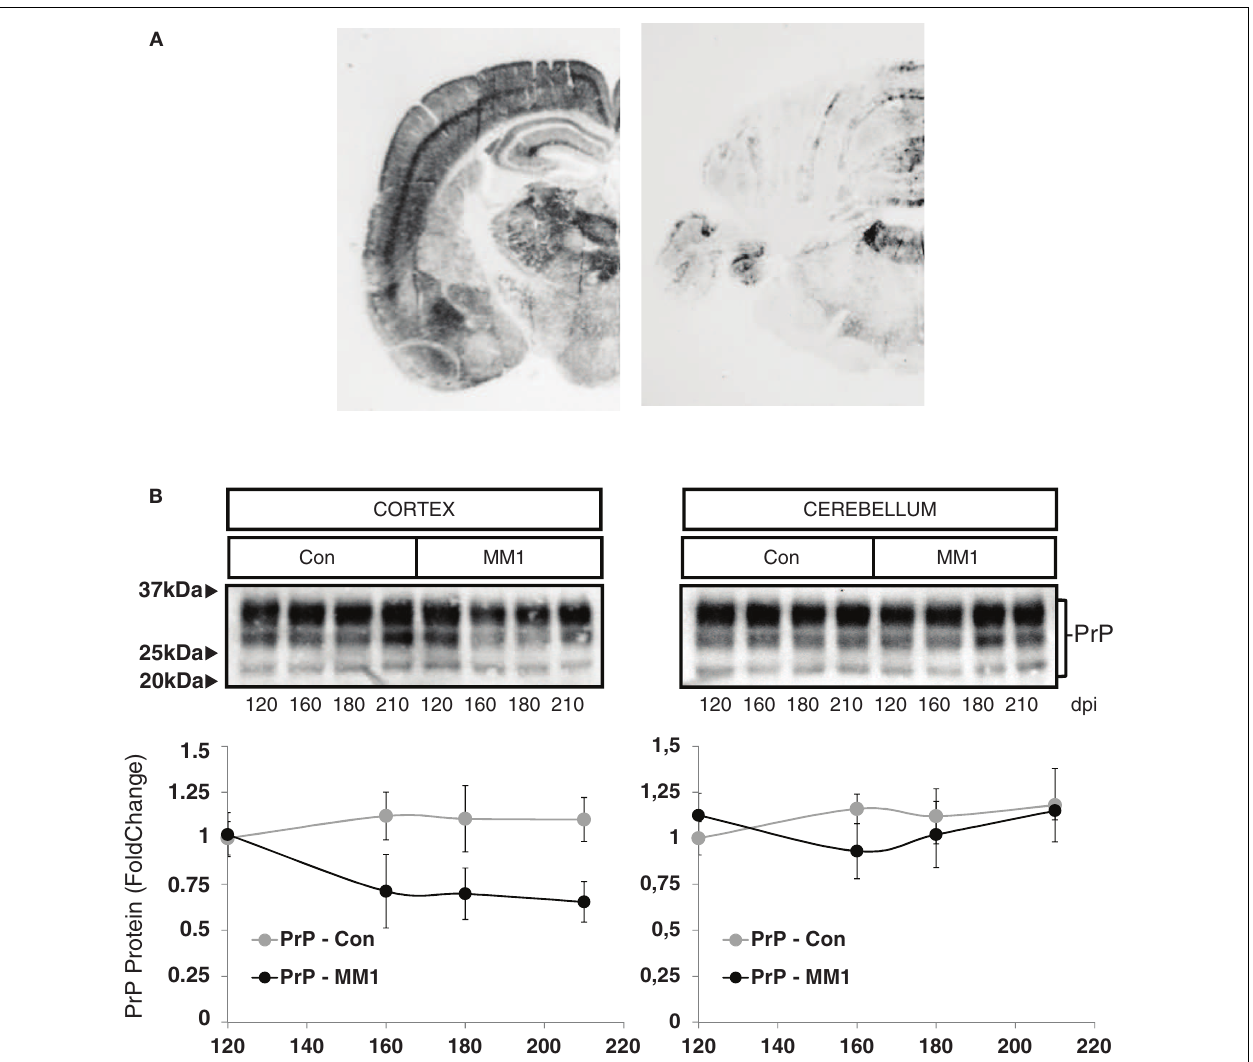
striatum, cerebellum, and dorsal midbrain. (B) PrP expression in the cortex and cerebellum of inoculated animals as revealed byWestern-blot analysis. Densitometry values of three animals/time point show a significant decrease in the expression of PrP at clinical stages in the cortex of sCJD MM1